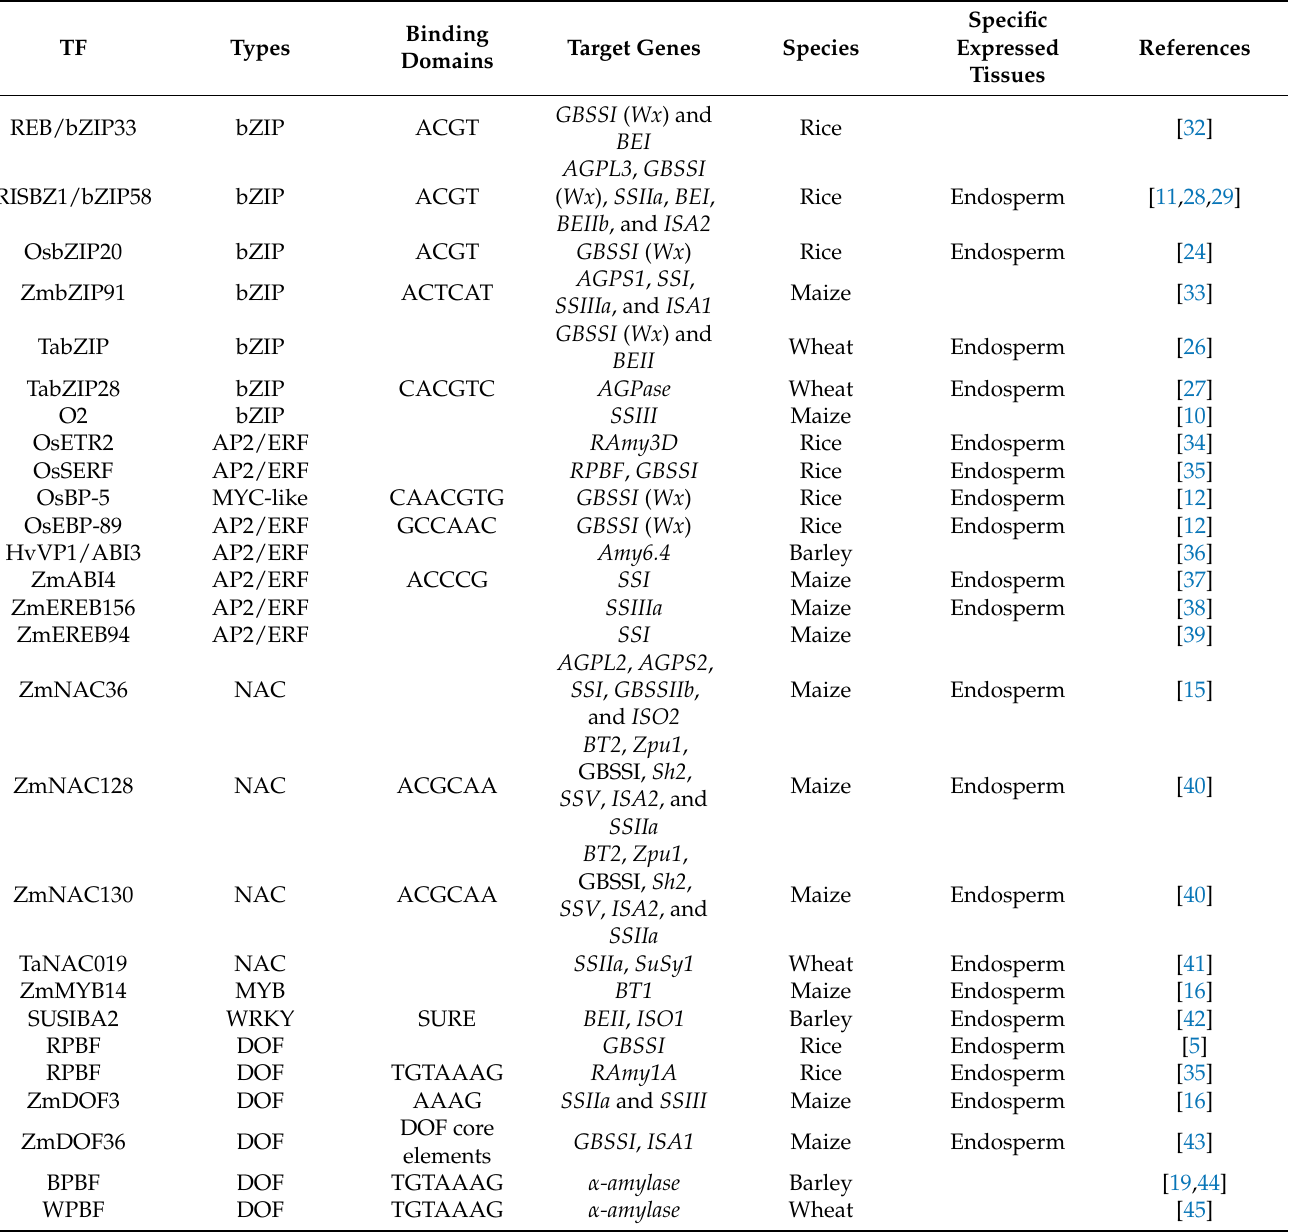
Table 1. Transcriptional factors directly regulating starch biosynthesis in cereal